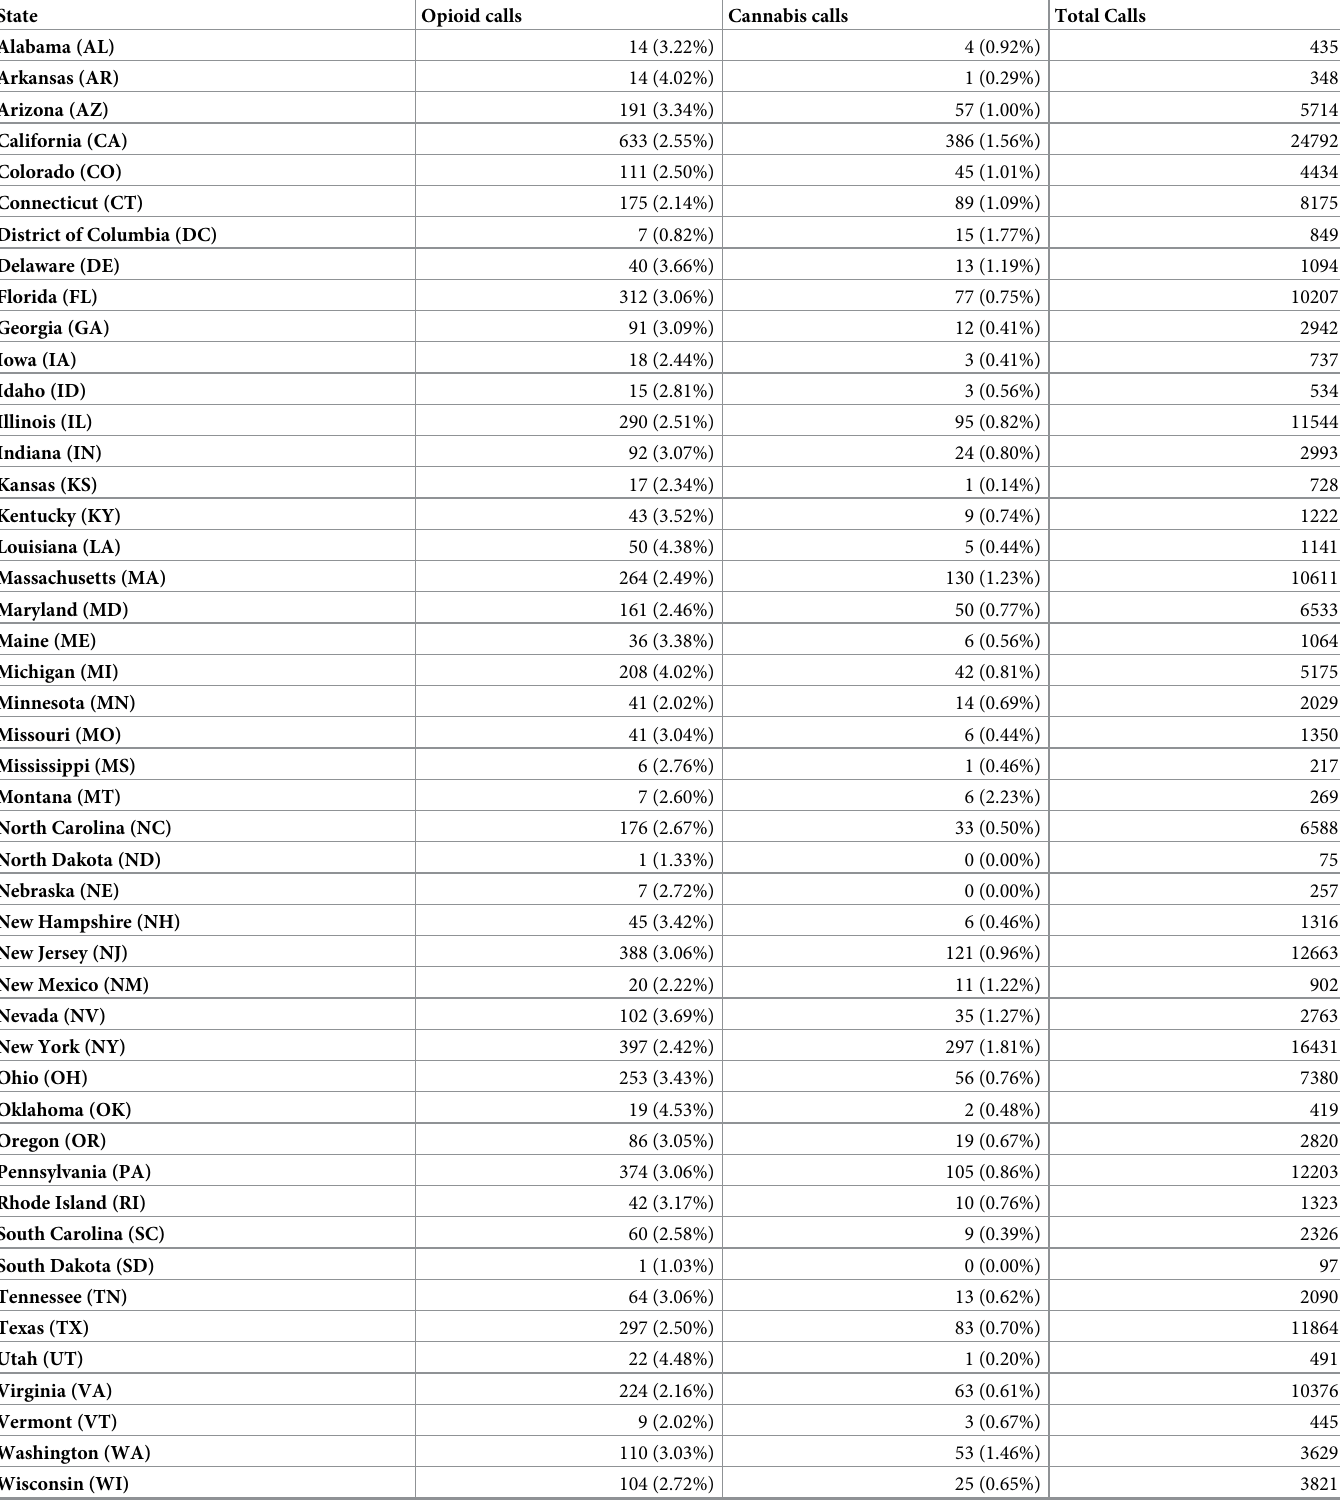
Table 2. Proportion of all household dog-associated poisoning calls to the APCC a related to an opioid or cannabinoid in each continental US state